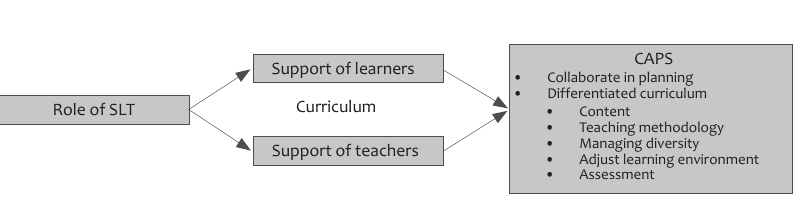
Figure 1: The collaborative role of the SLT within the CAPS